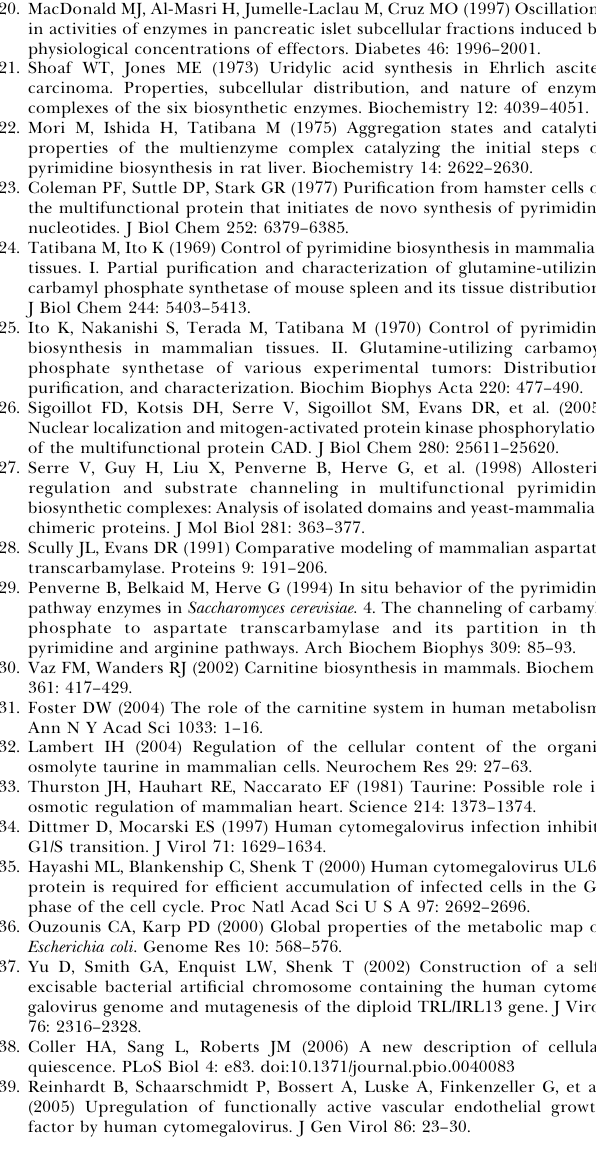
Table S1. Effect of HCMV on Metabolite Levels Table S2. Effect of HCMV on RNA Levels of ATP Syntheses (Mitochondrial Proton Transporting) Found at doi:10.1371/journal.ppat.0020132.st002 (46 KB